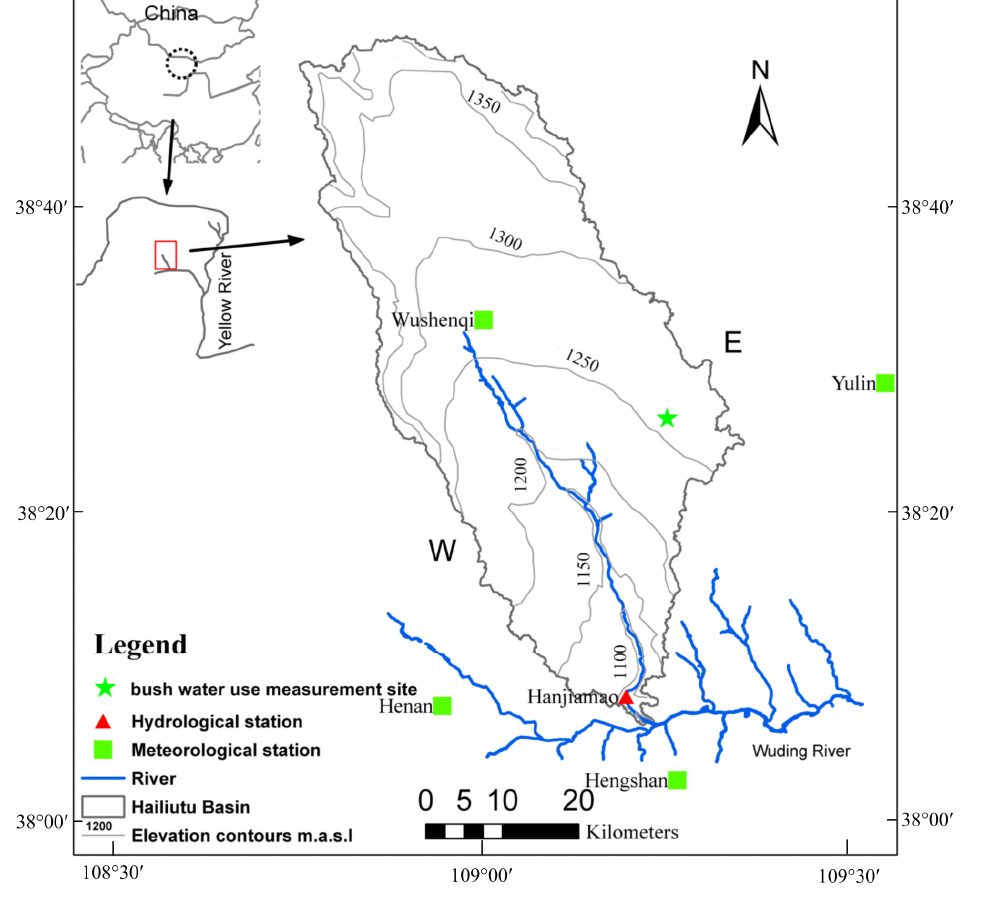
Figure 1. Location of the Hailiutu River catchment and the research site.